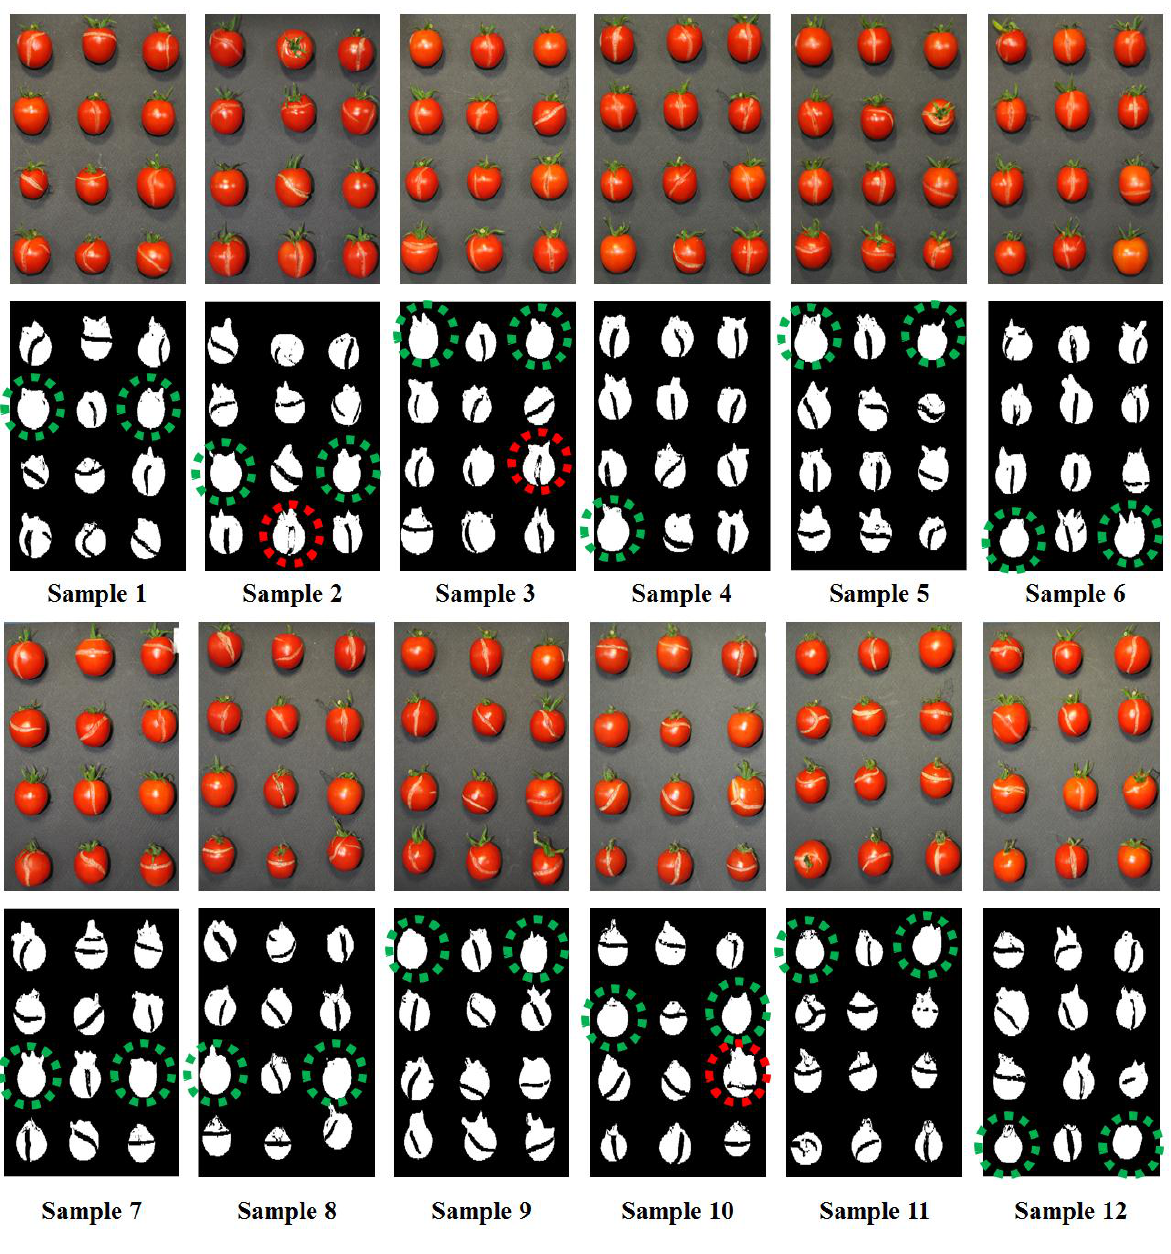
Figure 11. Resultant detection images.